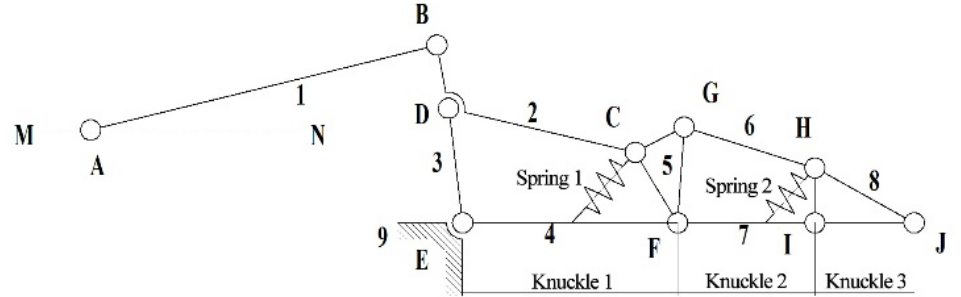
Figure 3. Finger mechanism of the underactuated manipulator.